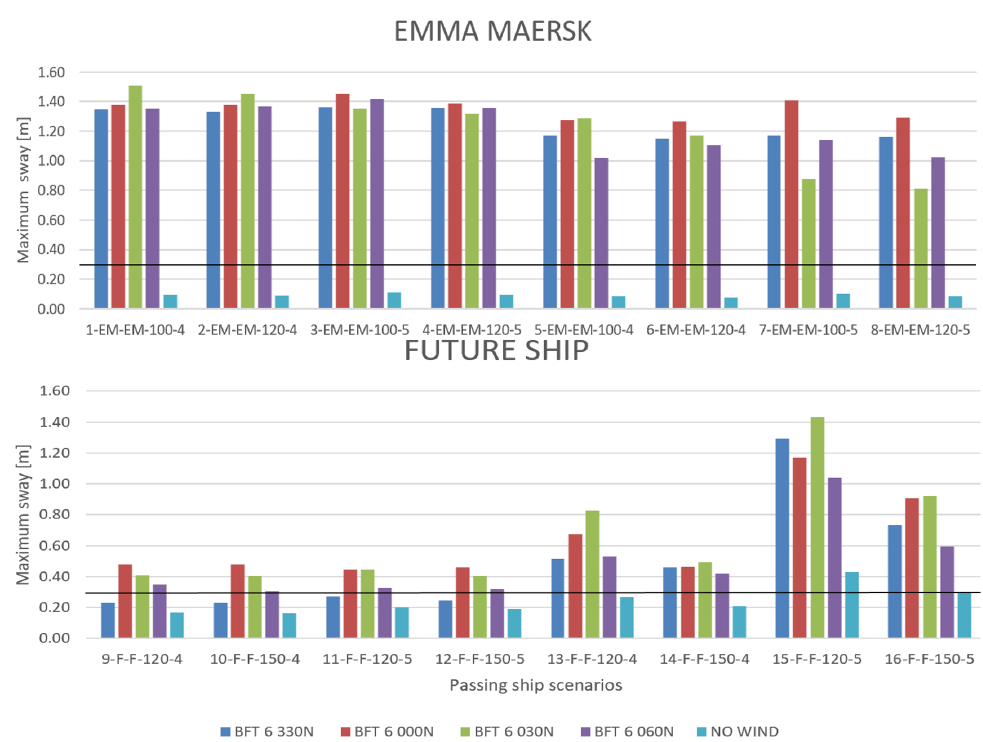
Figure 16. Maximum sway motion results for the Emma Maersk and the future vessel subjected to passing-ship